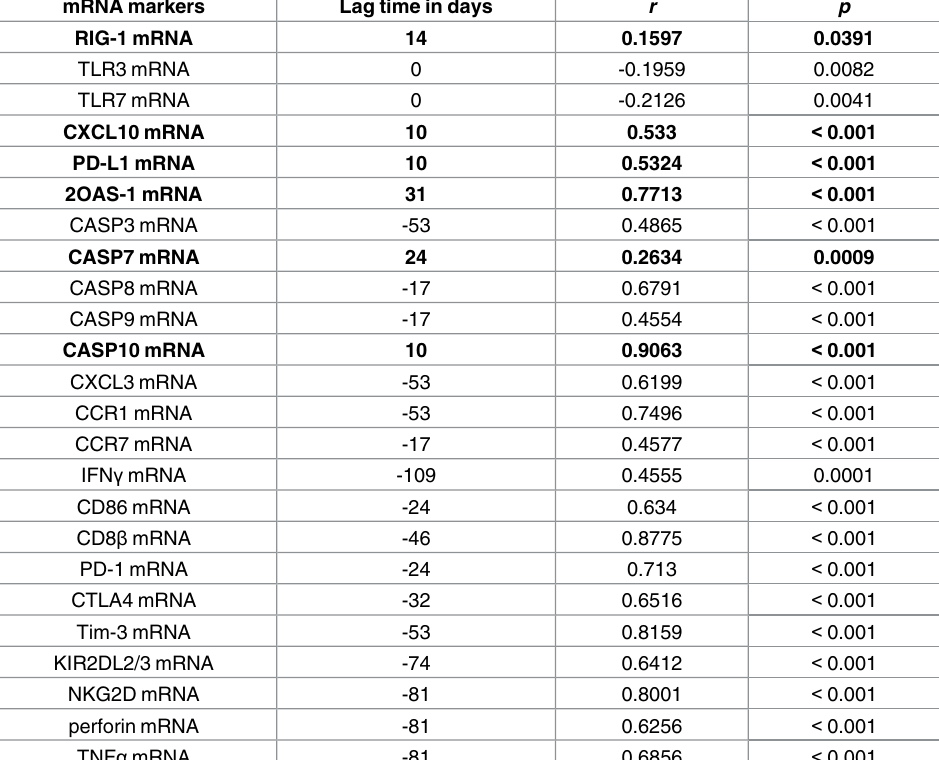
Table 2. Lag correlation coefficients between ALT activity and other markersbased on the Pearson correlation